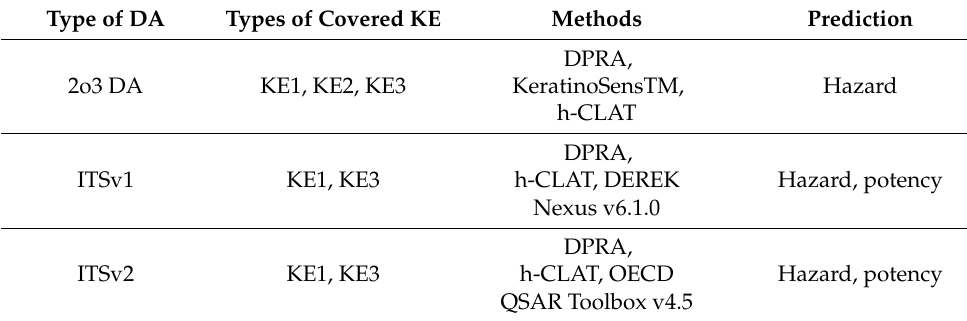
Table 1. Characteristic of DAs under OECD TG 497 [34,35]. Type of DA Types of Covered KE Methods